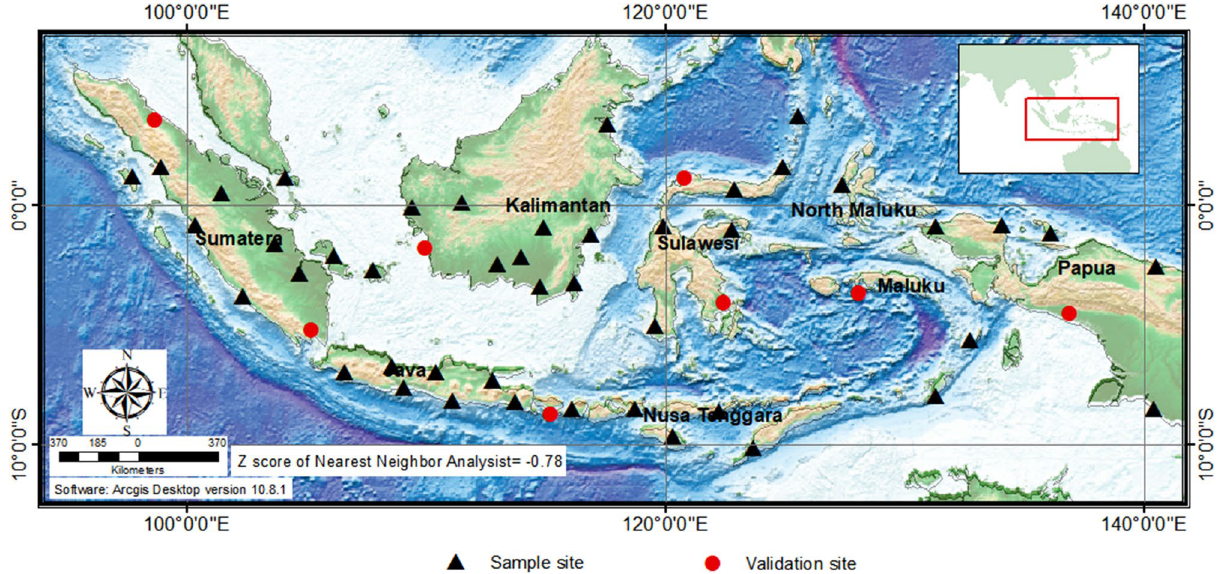
Figure 1. Distribution of the 45 sample locations and the 8 locations designated for data validation, Epoch 2010. The Z score is the nearest-neighbor analysis value; a negative score indicates cluster distribution. The base map is from DEMNAS (the national digital elevation model) publish by the National Mapping Agency of Indonesia (https:// tanah air. indon esia. go. id/ demna s/#/). The national bathymetry is generated from